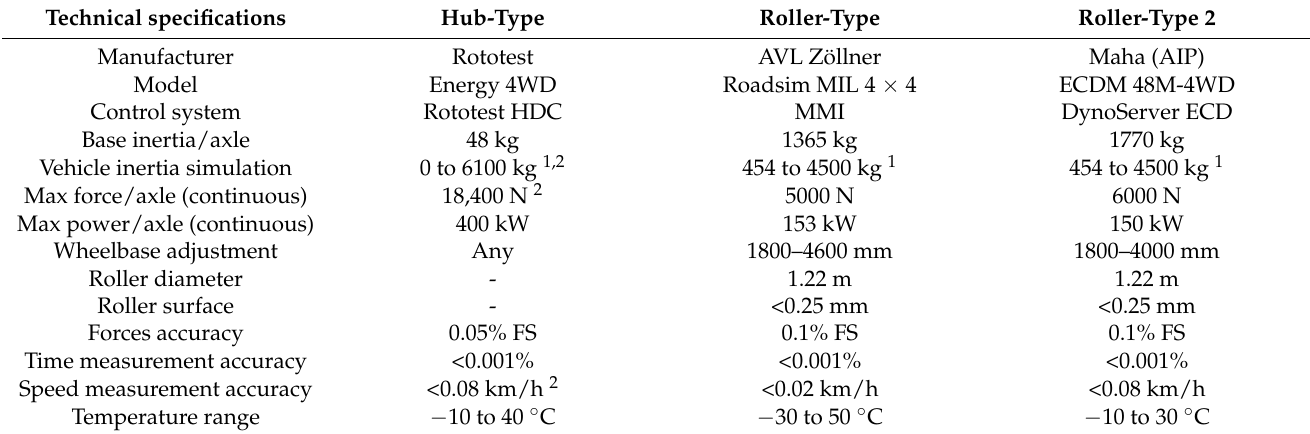
Table 1. Characteristics of